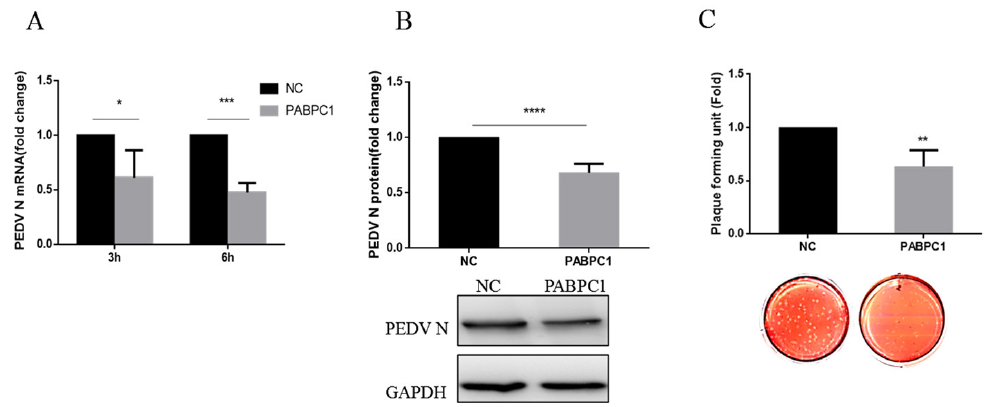
Figure 2. Overexpression of PABPC1 inhibits PEDV replication in Vero cells. ( A ) The mRNA expres- sion changes in N gene after the overexpression of PABPC1. ( B ) Changes in N-protein expression after the overexpression of PABPC1. ( C ) Changes in PEDV titers after the overexpression of PABPC1. Values represent means ± SD from three independent experiments. * means p < 0.05; ** means p < 0.01; *** means p < 0.001, **** means p <